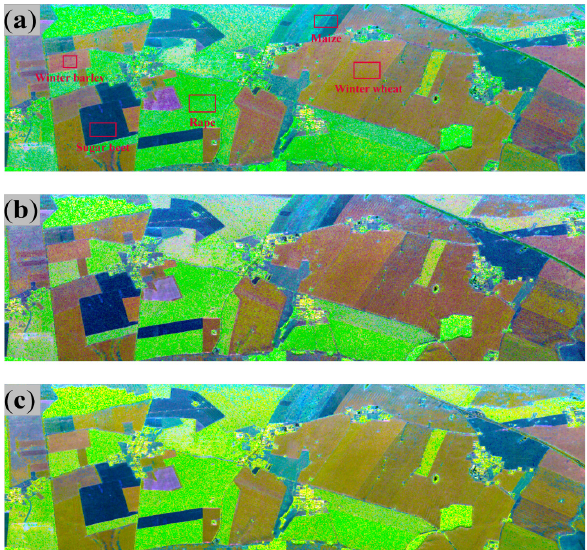
Figure 8. The color-coded images of the decomposition results for the E-SAR dataset (red: double- bounce; green: volume scattering; blue: surface scattering). ( a ) 5XD decomposition method. ( b ) 7SD decomposition method. ( c ) Proposed decomposition method.